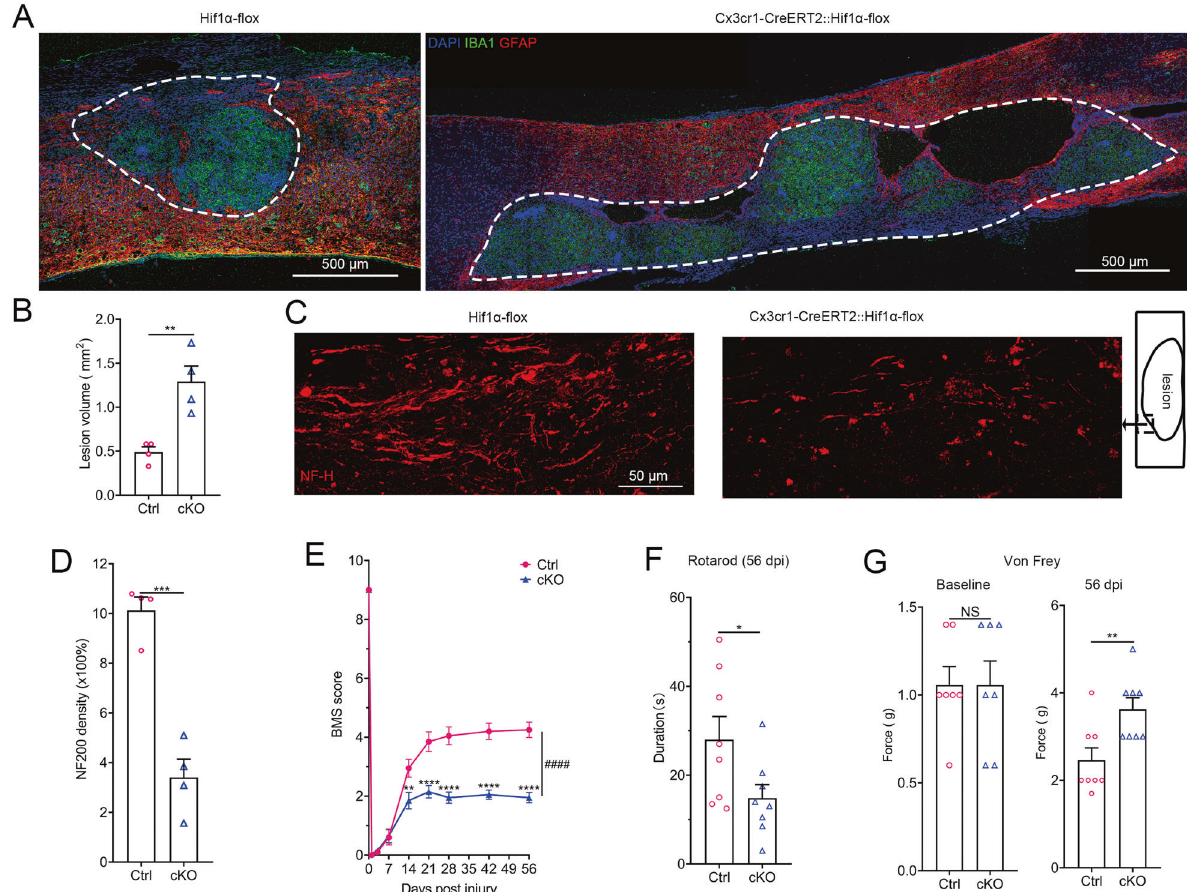
Fig. 6 Hif1 α is expressed in microglia and promotes functional recovery after SCI. A IHC images show the lesion sizes in Hif1 α cKO and control mice at 56 dpi. The dashed white line indicates the lesion border. Scale bar: 500 μ m. B Statistical histogram of A . n = 4 independent mice per group, unpaired two-tailed Student ’ s t -test, **P = 0.0052. C IHC images show axon fi bers in the lesion (NF-H) in Hif1 α cKO mice and control mice at 56 dpi. D Statistical histogram of C . n = 4 independent mice per group, unpaired two-tailed Student ’ s t -test, ***P = 0.0003. E BMS scores during the eight weeks of recovery after T10 contusion injury demonstrate an impaired functional recovery in Hif1 α cKO mice compared with littermate controls with the same tamoxifen regimen. n = 10 mice per group, two-way ANOVA-RM with Bonferroni post hoc correction, F (1, 162) = 107.3 for the column factor, F (8, 162) = 333.1 for the row factor. **P = 0.0025 , ****P < 0.0001, #### P < 0.0001. F Rotarod assays show impaired motor functional recovery in cKO mice compared to littermate controls at 56 dpi. n = 8 independent mice per group, unpaired two-tailed Student ’ s t -test, *P = 0.0459. G von Frey fi lament tests were performed at baseline and 56 dpi. n = 8 independent mice per group, unpaired two-tailed Student ’ s t -test, **P =